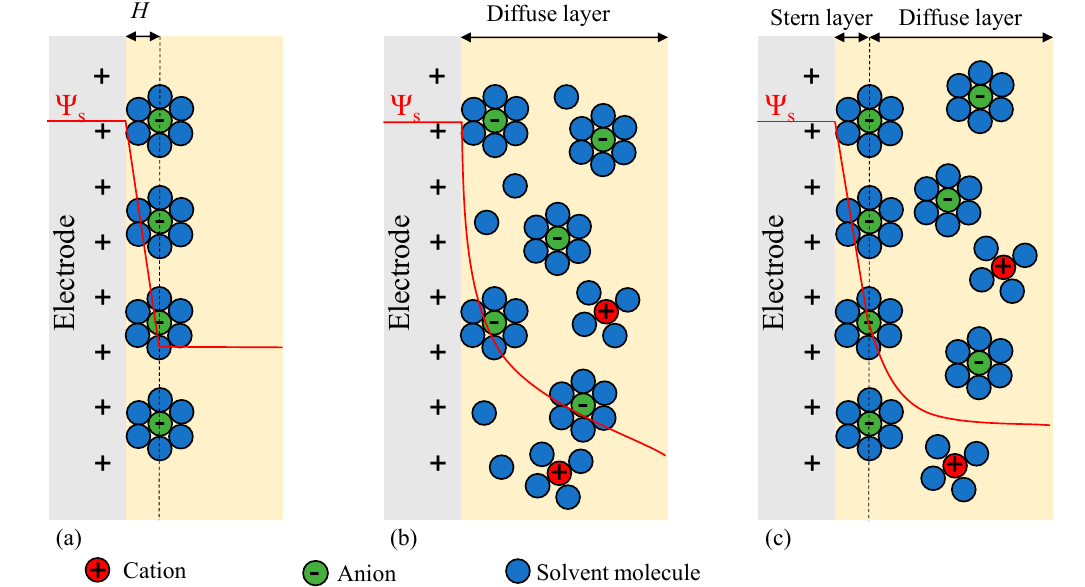
Figure 8. Schematics of the electric double − layer structure showing the arrangement of solvated anions and cations near the electrode/electrolyte interface in the Stern layer and the diffuse layer. Schematic of three basic electrochemical models of the supercapacitor: ( a ) Helmholtz model, ( b ) Chapman model, ( c ) combined mode. Reprinted with permission from Ref. [26] .